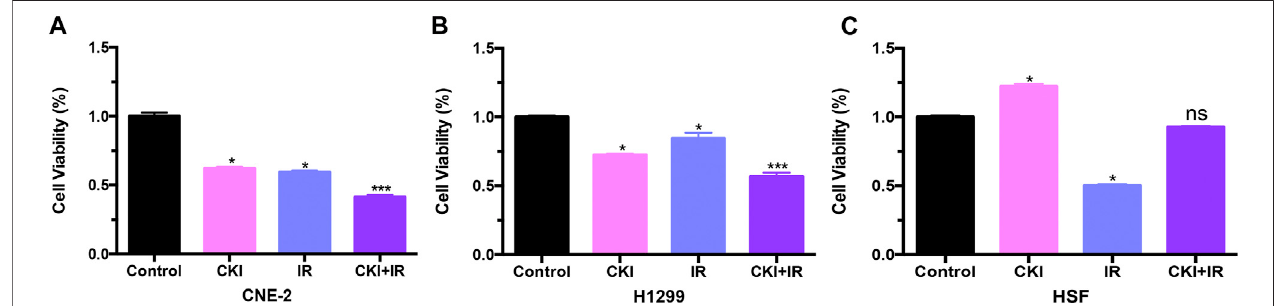
FIGURE 3| CKI combined with IR inhibited cancer cell growth additively, whilehad no obvious effect in HSF cells compared to control. (A – C) Cancer cells (CNE-2 and H1299) and HSF cells were treated with CKI (4 mg/ml), IR (4Gy), and CKI combined with IR. Afterwards, cell viability was analyzed using MTT assay. Values in bar graphs were given as the mean ± SD from three independent experiments performed in triplicate. *Indicates signi fi cant difference as compared to the untreated control group (* p < 0.05; ***, p < 0.001). ns, not signi fi cant, indicates no signi fi cant difference as compared to the untreated control